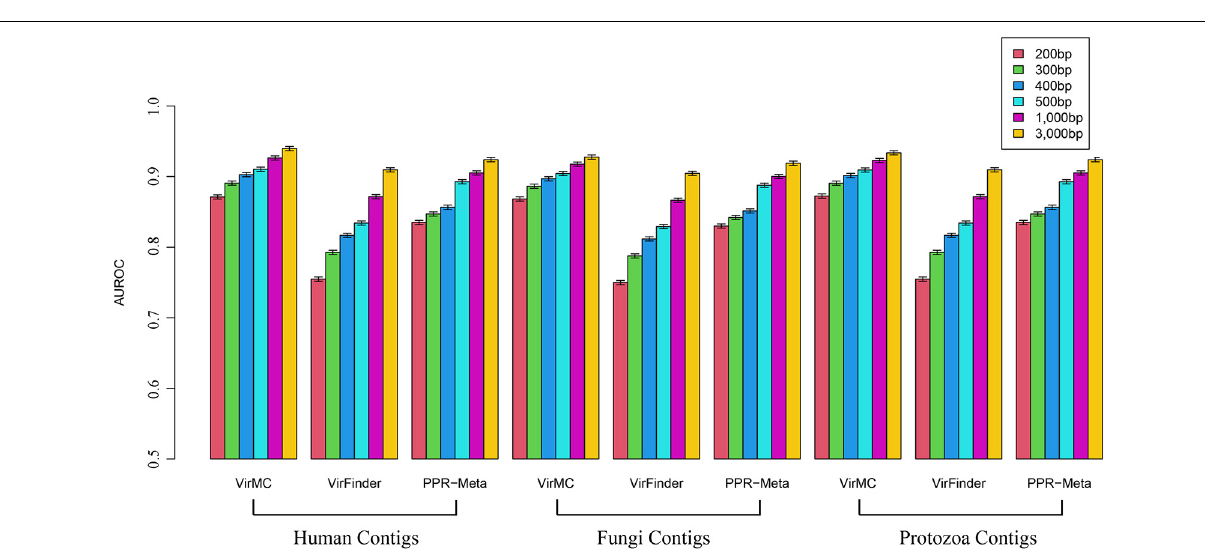
FIGURE 4 | The False Positive Rates of VirMC, VirFinder, and PPR-Meta for classifying eukaryotic contigs from Human, Fungi, and Protozoan. The eukaryotic genomes were divided into fragments of different lengths and then used for evaluation.